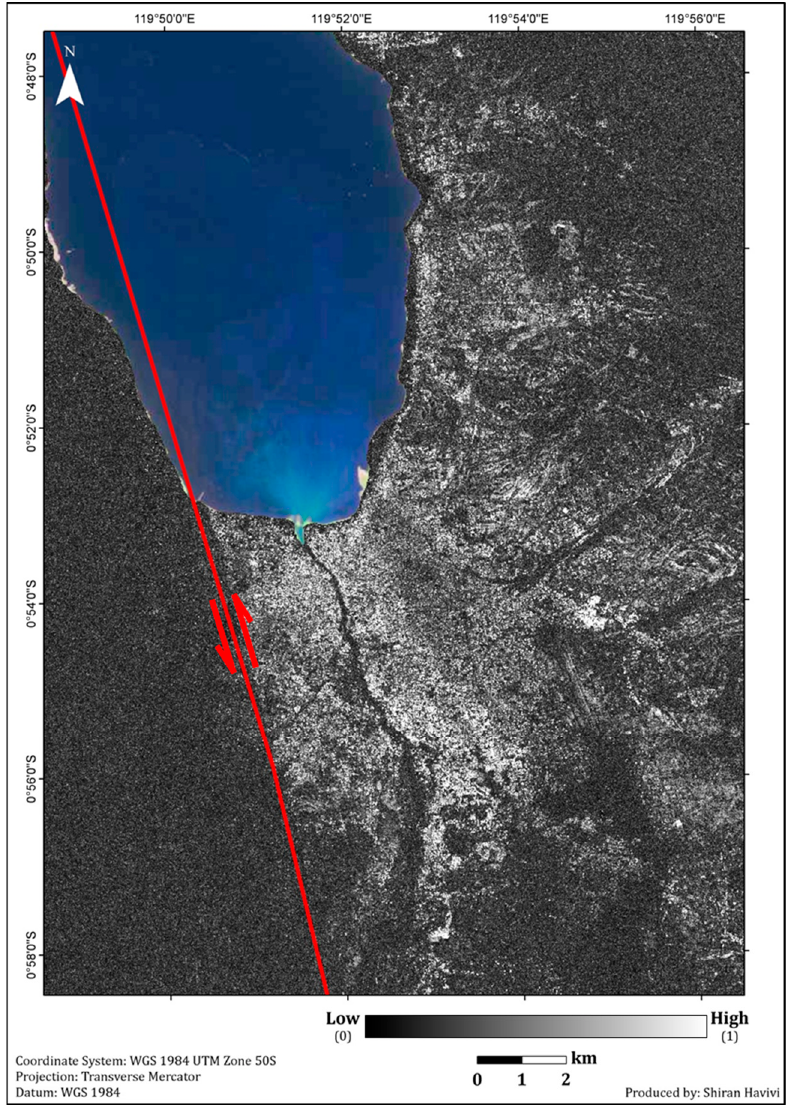
Figure 4. InSAR coherence map. Light tones (high coherence values) represent no change. Dark tones represent changes (low coherence values). The red line represents the Palu-Koro Fault. The red arrows show the dominate left-lateral movement of PKF, with trend of NNW–SSE and N-S.